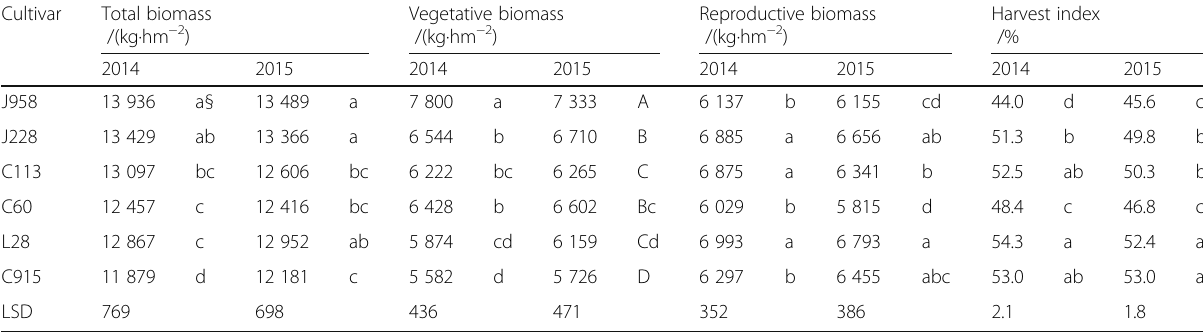
Table 3 Effect of cotton cultivar on cotton biomass accumulation and biomass partitioning in 2014 and 2015 Cultivar